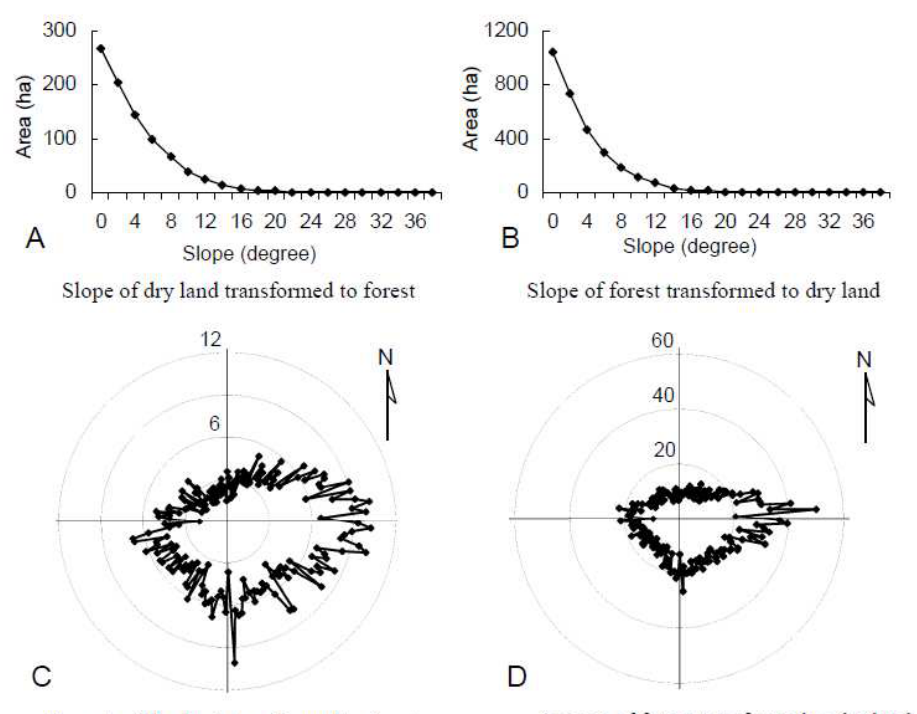
Figure 5. Dry land and forest on sloped land over 4 degrees in